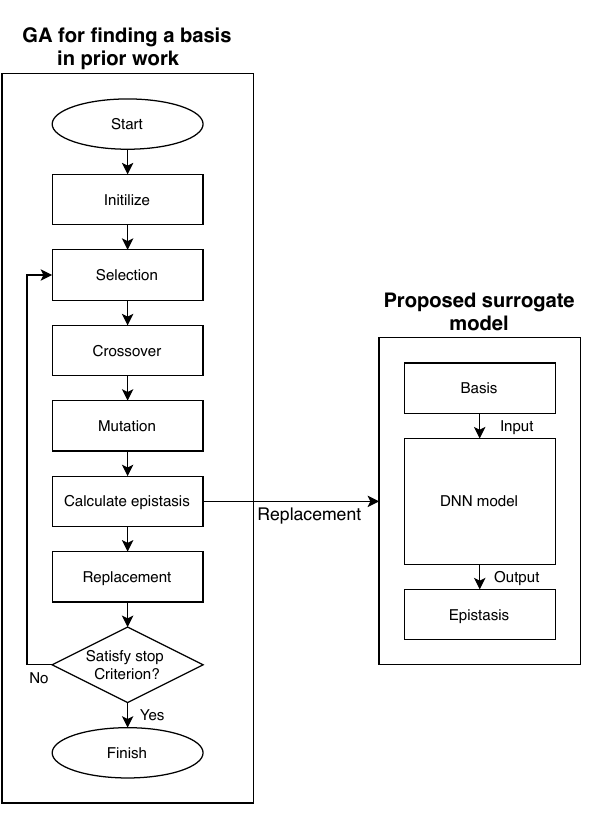
Figure 2. Flowchart of our genetic algorithm (GA) [10] combined with the proposed surrogate model.